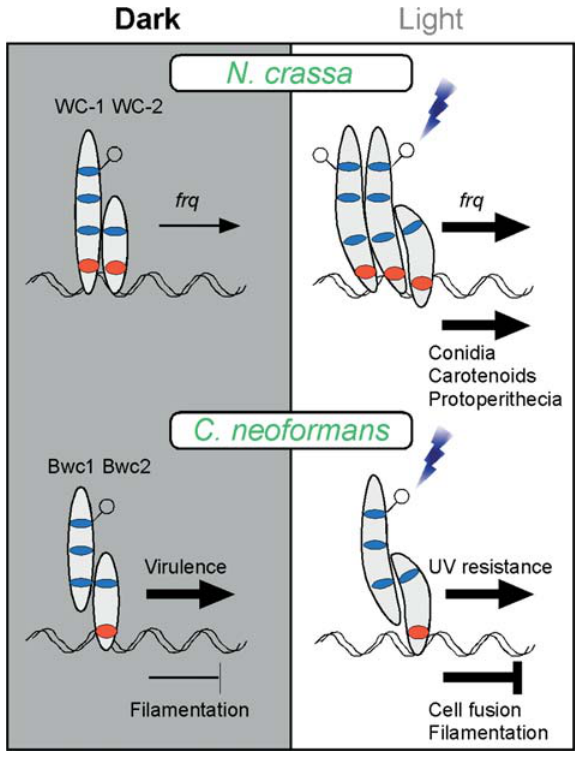
Figure 9. A Model of How Two Fungi May Respond to Light The Bwc1-Bwc2 interaction of C. neoformans shares conserved features with the WC-1-WC-2 interaction of N. crassa but also exhibits unique functional characteristics. In this model, C. neoformans Bwc1-Bwc2 bind to DNA in the dark and act as weak repressors to reduce filament development. We hypothesize that photons perceived through a proposed flavin moiety on Bwc1 cause a conformational change that increases repression of filament formation and cell fusion, and activates transcription of genes required for UV resistance. Alternatively, UV sensitivity may be mediated through repression by Bwc1-Bwc2 of a repressor protein. The N. crassa model is simplified from [3]: a complex of two units of WC-1 forms in response to light to cause an initial up-regulation of frq transcription above the levels occurring in the dark (FRQ feedback inhibits the White collar complex). The complex also increases transcription of genes required for other processes. DOI: